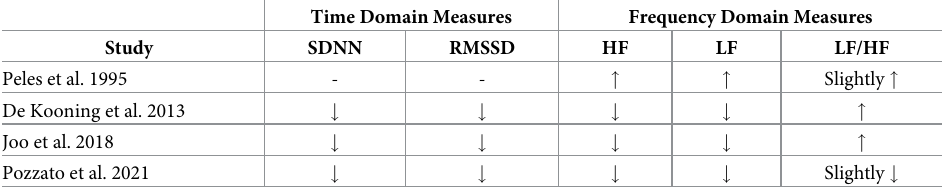
Table 2. The most reported heart rate variability parameters in the included studies and the direction of effect.